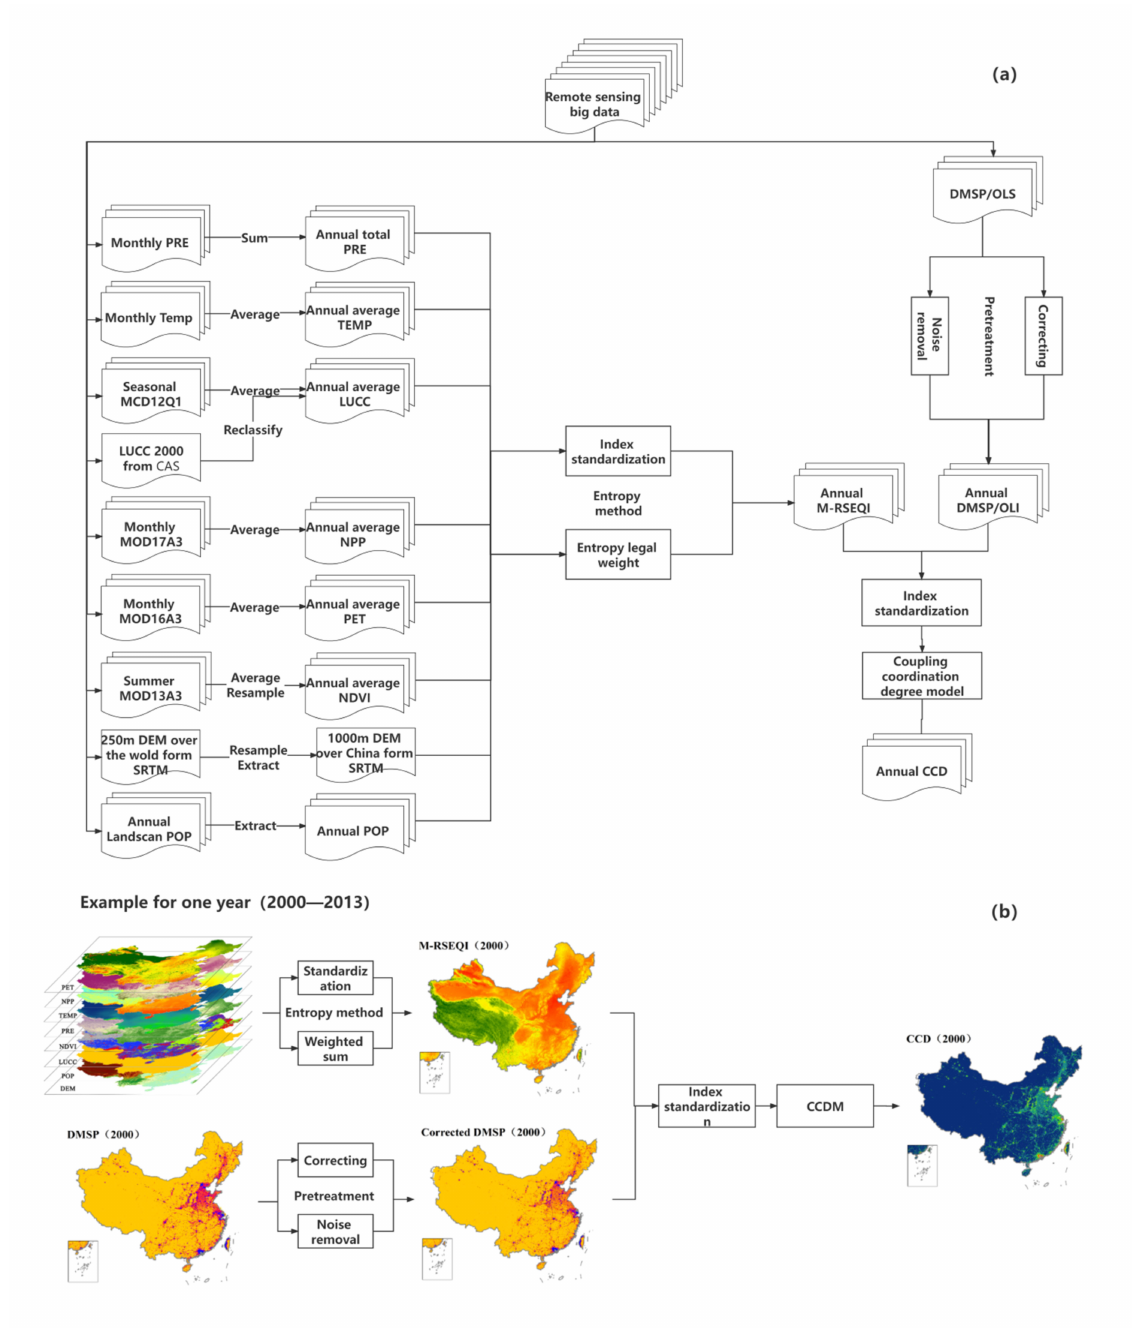
Figure 2. Flowchart of the methods. ( a ) The flowchart of data processing methods; ( b ) An example for one year